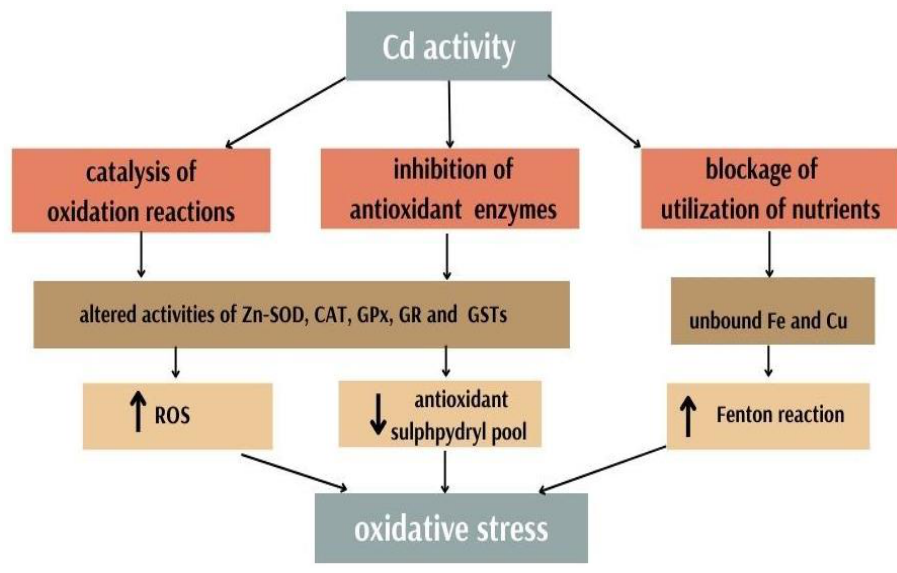
Figure 2. Cadmium activity and oxidative stress generation.